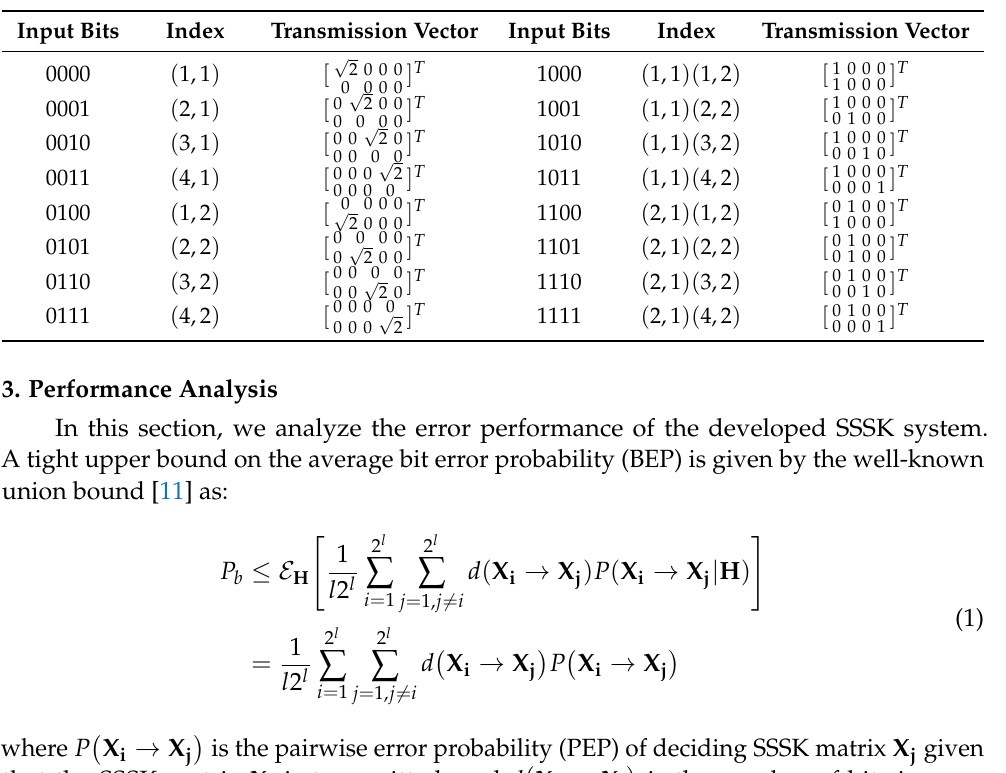
Table 2. Example of the SSSK mapper